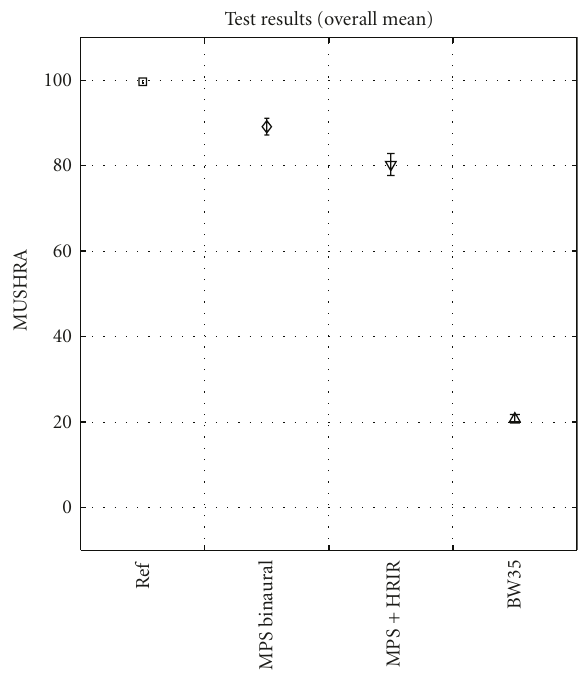
Figure 10: Overall mean scores (across excerpts and subjects) for the morphed-filter approach. Error bars denote the 95% confidence intervals of the